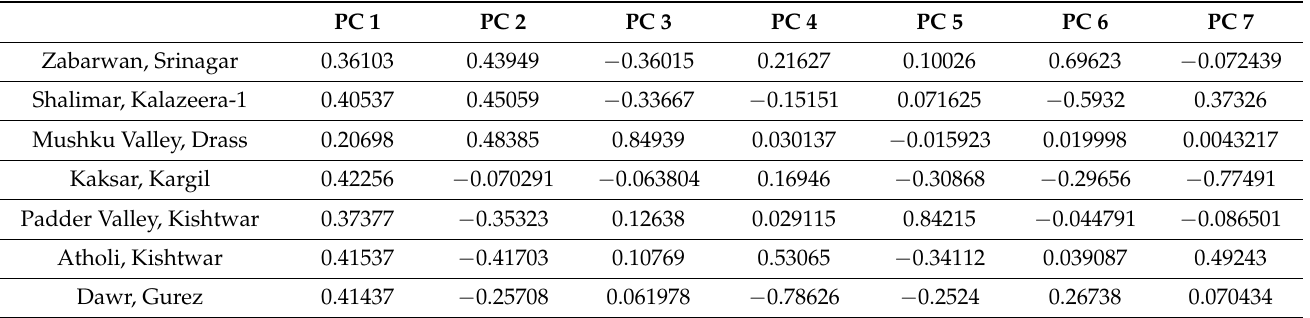
Table 3. Principal component analysis (PCA) loadings between seven climate zones of Northwestern Himalayas .